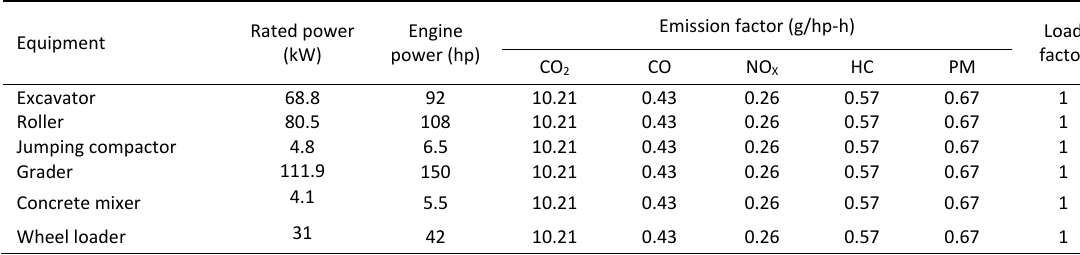
Table 1: Measured parameters for air pollutant emissions’ calculation